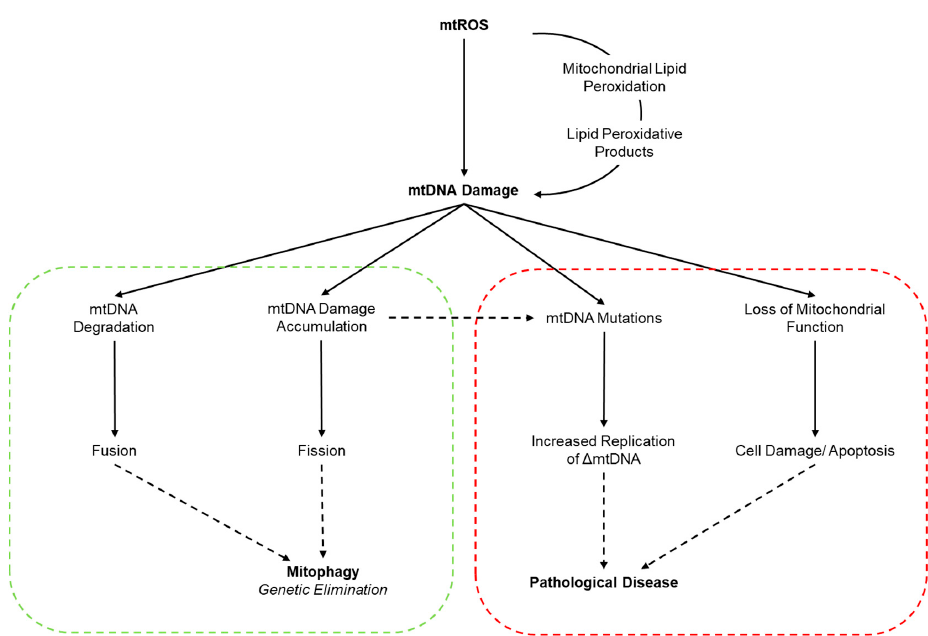
Figure 1. Cellular responses and downstream effects of mtDNA damage. The increased generation of ROS (and/or loss of mtDNA repair), and increase in lipid peroxidative products can potentiate mtDNA damage. Green shading represents the physiological and protective responses to mtDNA damage whereby mitochondria with excessive damage are segregated and compensated via fission and/or fusion, respectively, and are subsequently removed by mito/autophagy. Red shading indicates pathophysiological responses to mtDNA damage whereby excessive mtDNA damage can result in mtDNA mutations and eventual heteroplasmy; thus, causing a loss of mitochondrial function and potentially leading to organ pathology and disease. Adapted with permission from Van Houten et al. [30].